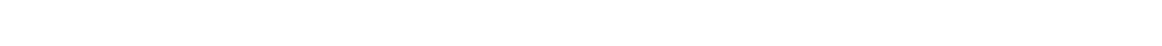
FIGURE 1 | Structural comparisons of TLS enzymes. Major functional domains are indicated. Not drawn to scale. Key: PCNA, proliferating cell nuclear